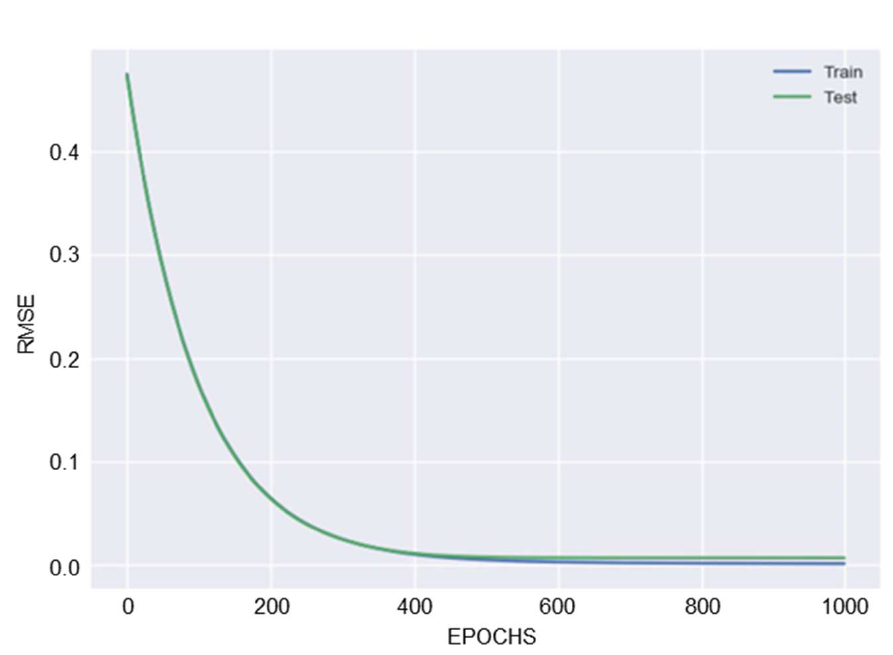
Figure 6. Learning curve for the XGBoost model with respect to RMSE for 1000 epochs using Randomized Search CV from scikit-learn.